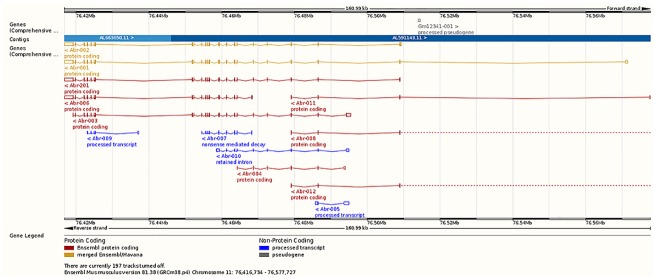
Relative location of the active BCR-related gene (Abr) transcript isoforms associated with an alternative splicing event between microglia and macrophages (Ensembl, http://www.ensembl.org).Red denotes Ensembl protein coding, orange denotes merged Ensembl/Havana protein coding, and blue denotes processed transcript non-protein coding.